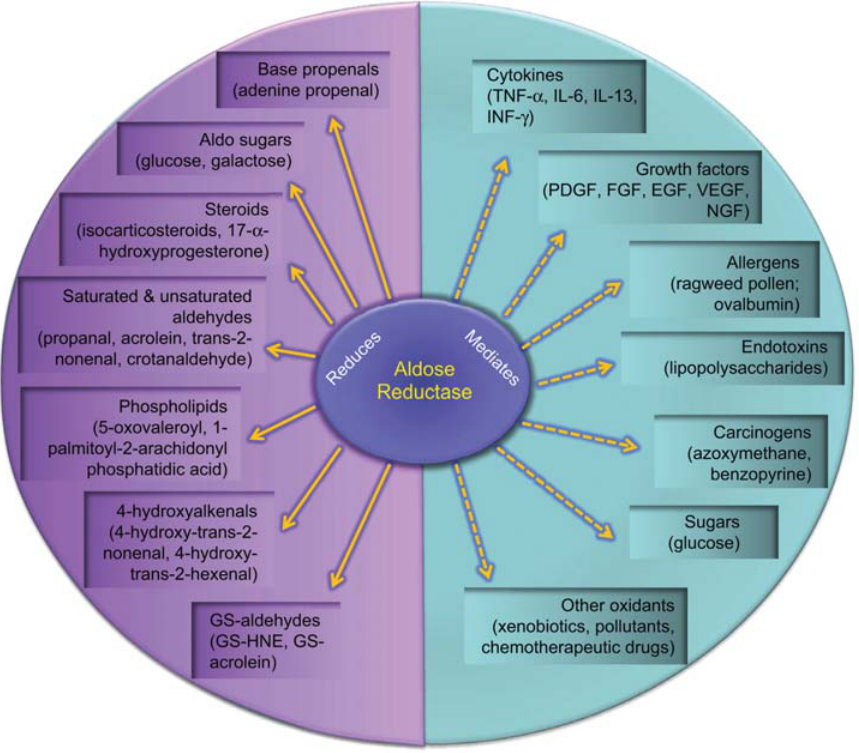
Figure 2 Aldose reductase catalyzes a wide array of substrates and regulates cellular signals initiated by various